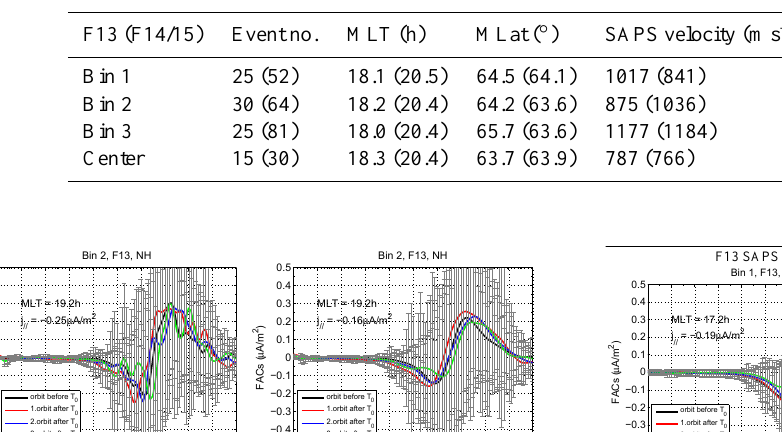
Table 1. The columns from left to right give the numbers of CHAMP orbits, the average spatial location (MLT and MLat) and peak velocity of F13 (14/15) SAPS, and the mean Kp index and SZA in each MLT bin.